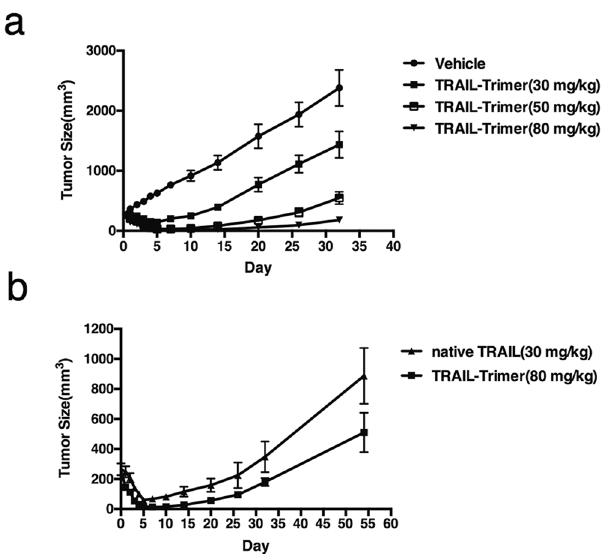
Figure 6. In vivo antitumor activities of TRAIL-Trimer and native TRAIL. ( a ) Nude mice with established COLO205 xenografts were given TRAIL-Trimer (30, 50, or 80 mg/kg/day) or vehicle as an i.v. bolus for 5 consecutive days (n = 6/group). Results shown are group mean ( ± S.D.). ( b ) Nude mice with established COLO205 xenografts were given the same molar concentration of TRAIL-Trimer and native TRAIL. Results shown are group mean ( ±